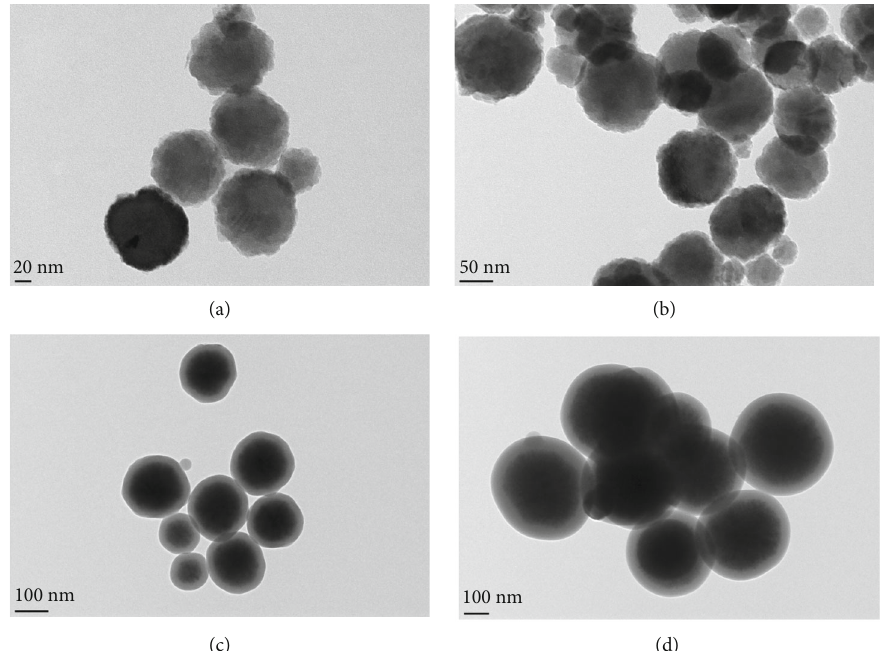
Figure 2: TEM images of (a, b) Fe